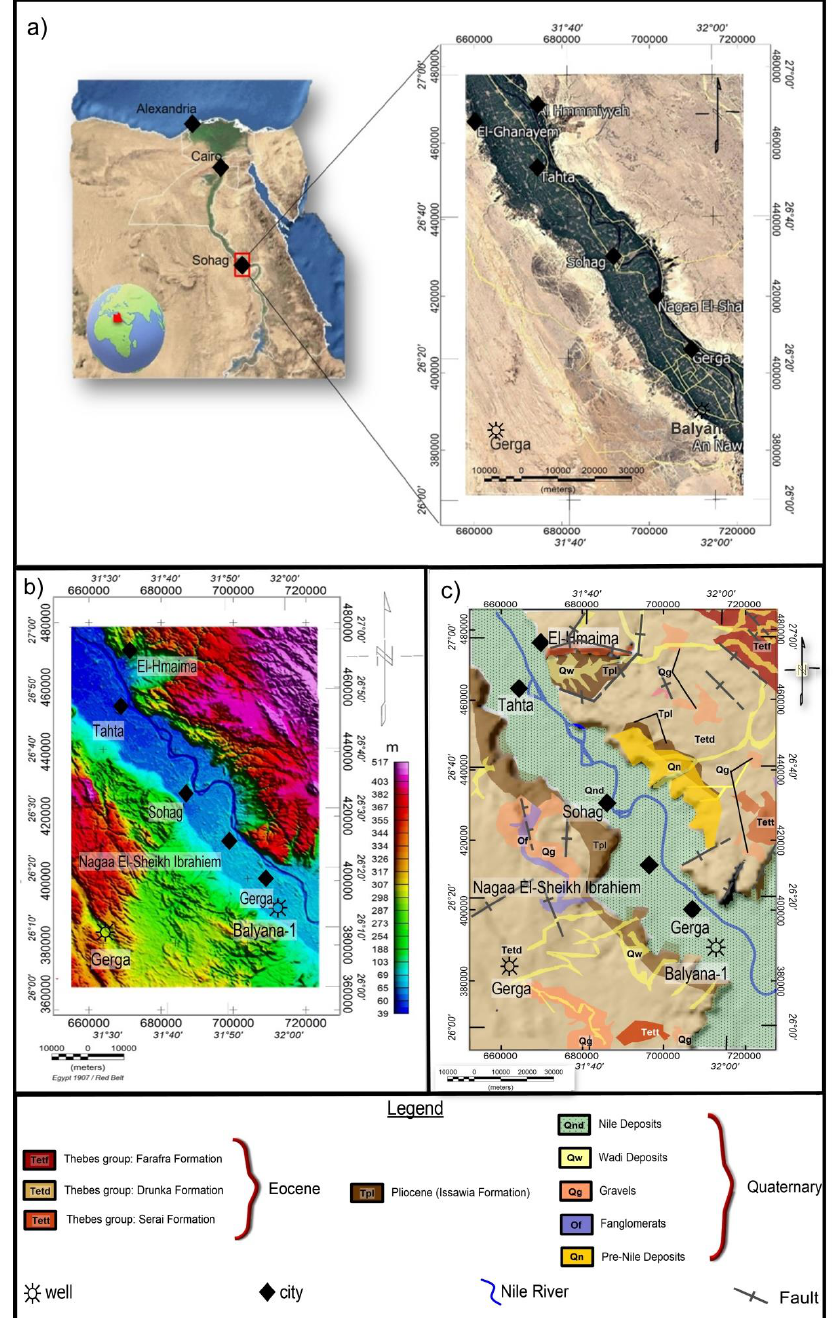
Figure 2. ( a ) Location map of Sohag sector, ( b ) Shuttle Radar Topography Mission (SRTM) map, showing the elevation distribution of the study area, and ( c ) geologic map of the study area showing the main surface rock units and faults affecting the area (after [28]).